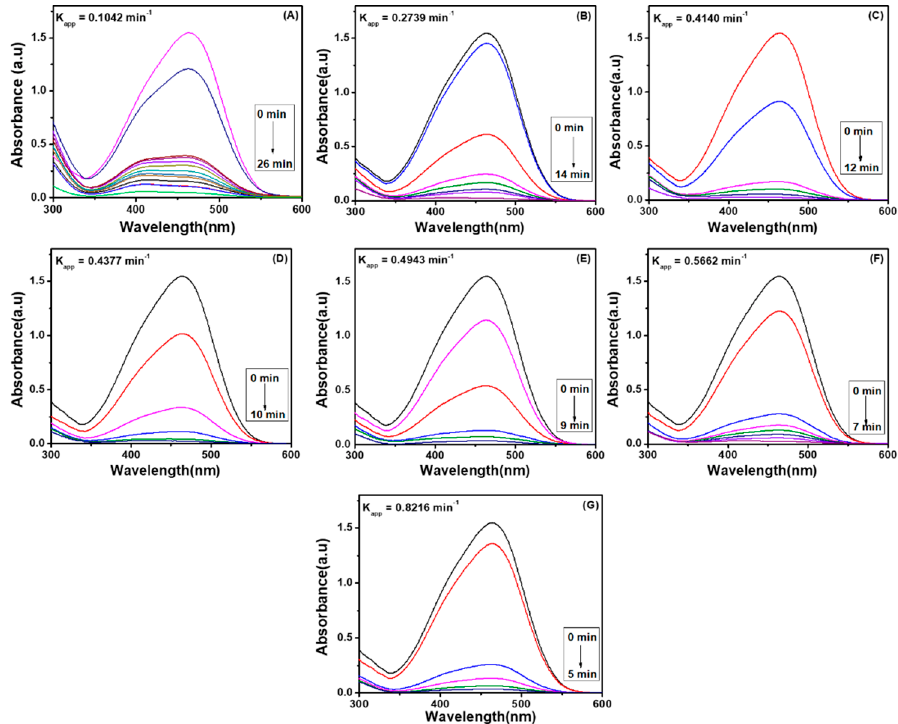
Figure 4. UV-Visible spectra for degradation of Methyl orange (dye) and its apparent rate constant values by using Ag-embedded NIPAM-based cryogels (CR-Ag) at different temperatures: ( A ):25 °C ( B ) 30 °C ( C ) 31 °C ( D ) 32 °C ( E ) 33 °C ( F ) 35 °C ( G ) 40 °C.